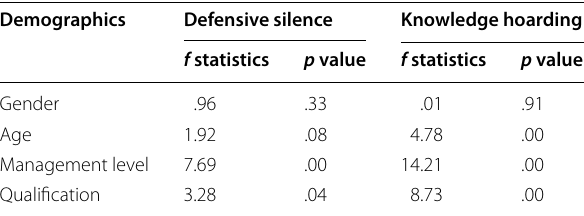
Table 1 One-way ANOVA for identification of control